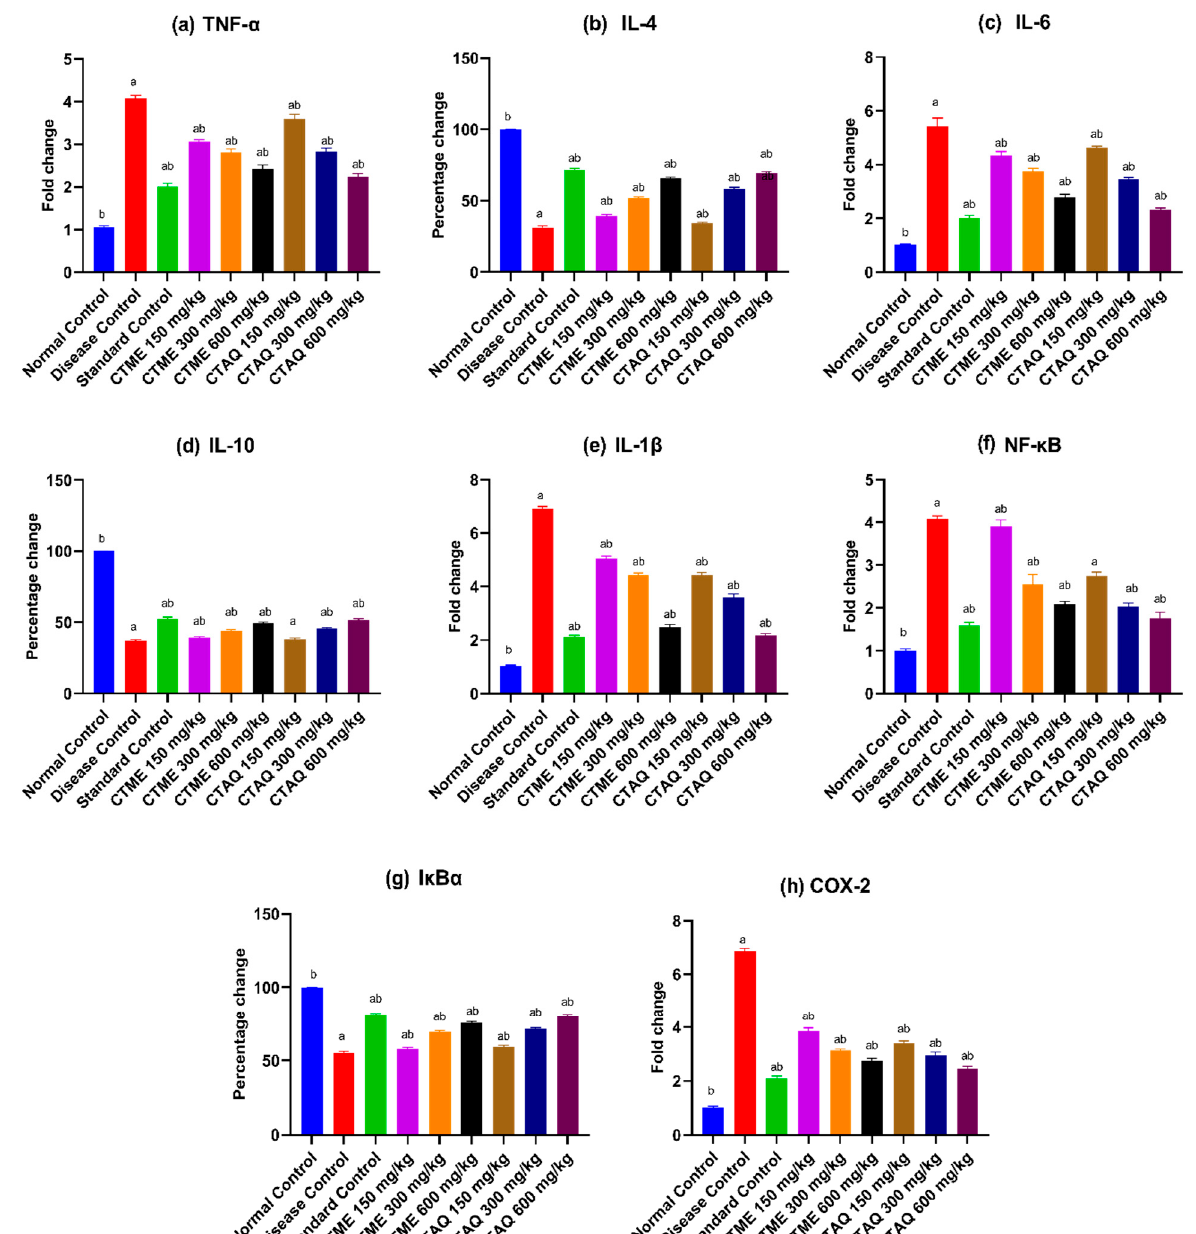
Figure 10. Effect of C. tuberculata extracts on gene expression in arthritic rats. Values as mean ± S.D ( n = 6). Here ‘a’ and ‘b’ showed significantly different at p < 0.0001 in contrast to NCG and DCG respectively.